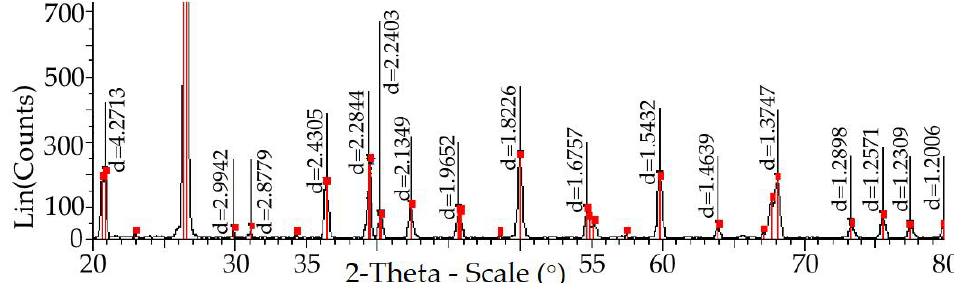
Figure 7. The diffractogram of the structure of quartzite dried at 200 ◦ C and cooled to 25 ◦ C. At a temperature of 200 ◦ C, there was only a change in the content of these unit cells.